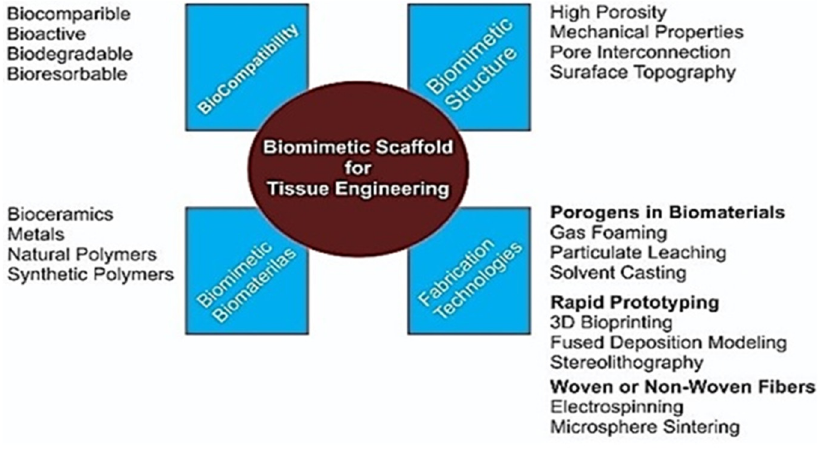
Figure 5. Key properties desired for a biomimetic scaffold for tissue engineering. (Reproduced from [193] with permission from the publisher).